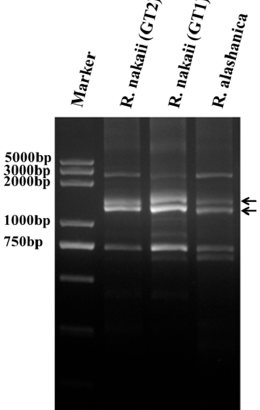
Figure 2. Electrophoretic profiles of PCR products corresponding to the complete coding sequences of HMW-GS genes from R. nakaii and R. alashanica . The target bands are indicated by arrows.